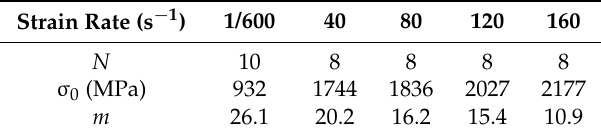
Table 2. Weibull parameters for tensile strength of glass yarn under different strain rates.